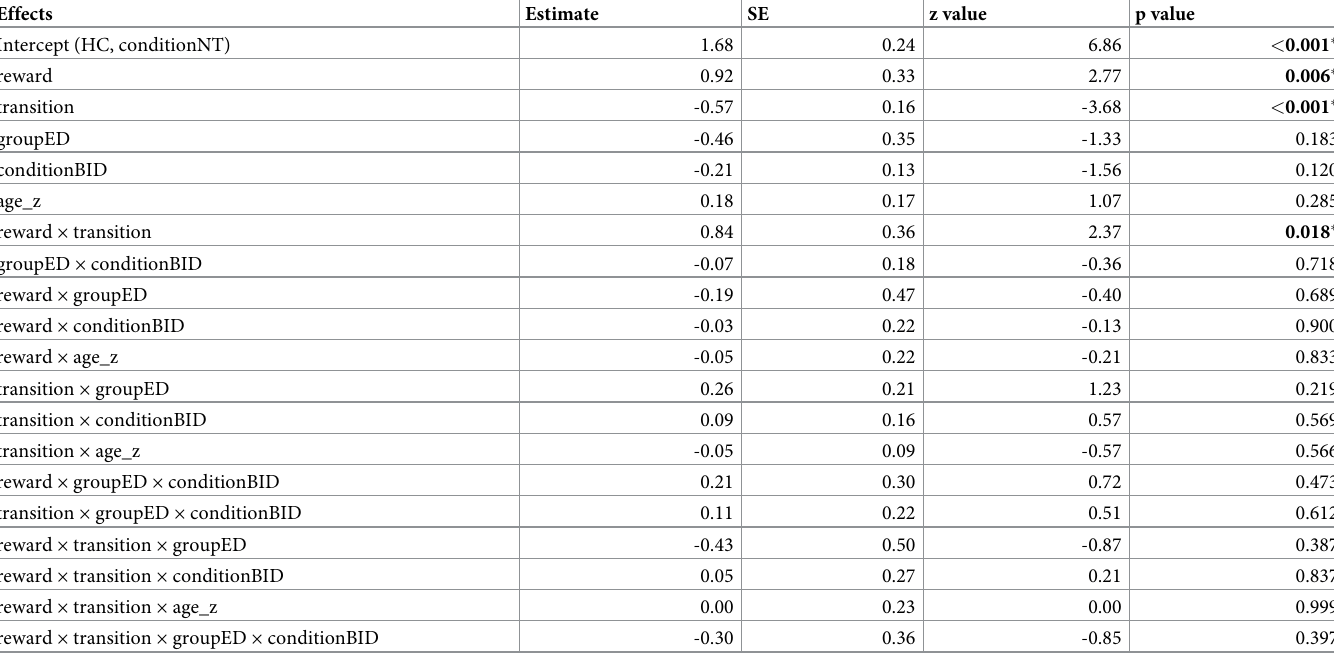
Table 3. Random effects logistic regression for probability of staying (collected data).